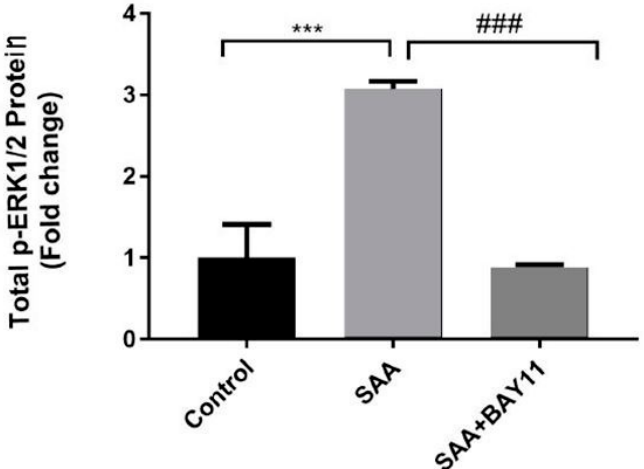
Figure 6. ERK1/2 levels in aortae homogenates. Total phosphorylated ERK1/2 (p-ERK1/2) protein